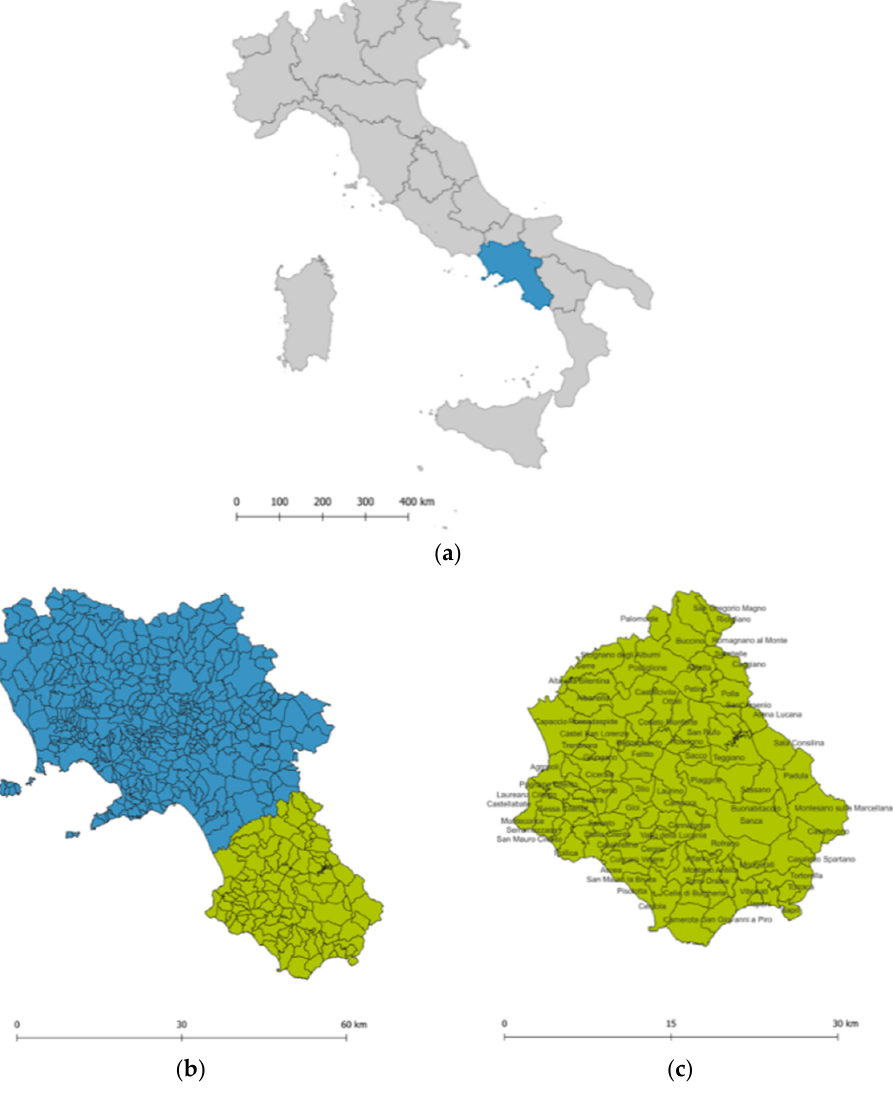
Figure 1. Maps for locating the study site. Notes: ( a ). Italy with the location of the region Campania; ( b ). the location of Cilento in the region Campania 1 ( c ). the territorial area of Cilento with the location of the 102 municipalities.